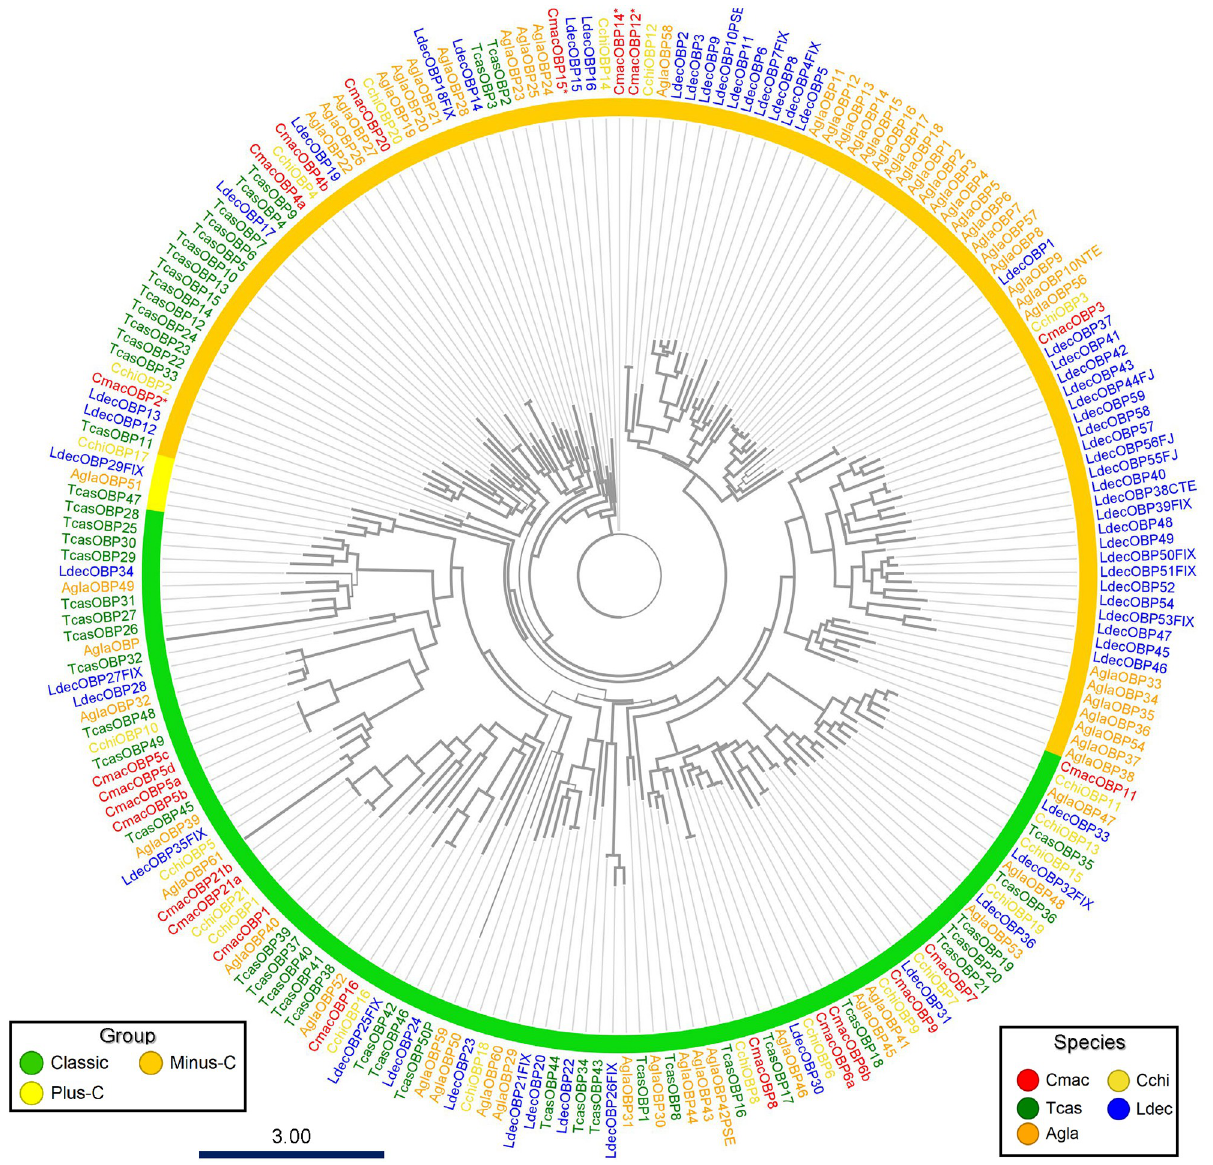
Fig 5. Maximum-likelihood phylogenetic tree of putative Callosobruchus maculatus odorant-binding proteins (OBPs) with insect OBP sequences from Anoplophora glabripennis (Agla), Leptinotarsa decemlineata (Ldec), Tribolium castaneum (Tcas), and Callosobruchus chinensis (Cchi). Thick nodes are supported by a bootstrap value > 60%. The rate of amino-acid substitutions per site is shown in the scale bar. The four CmacOBPs suffixed with asterisks were a perfect match between the antennal transcriptome and genomic